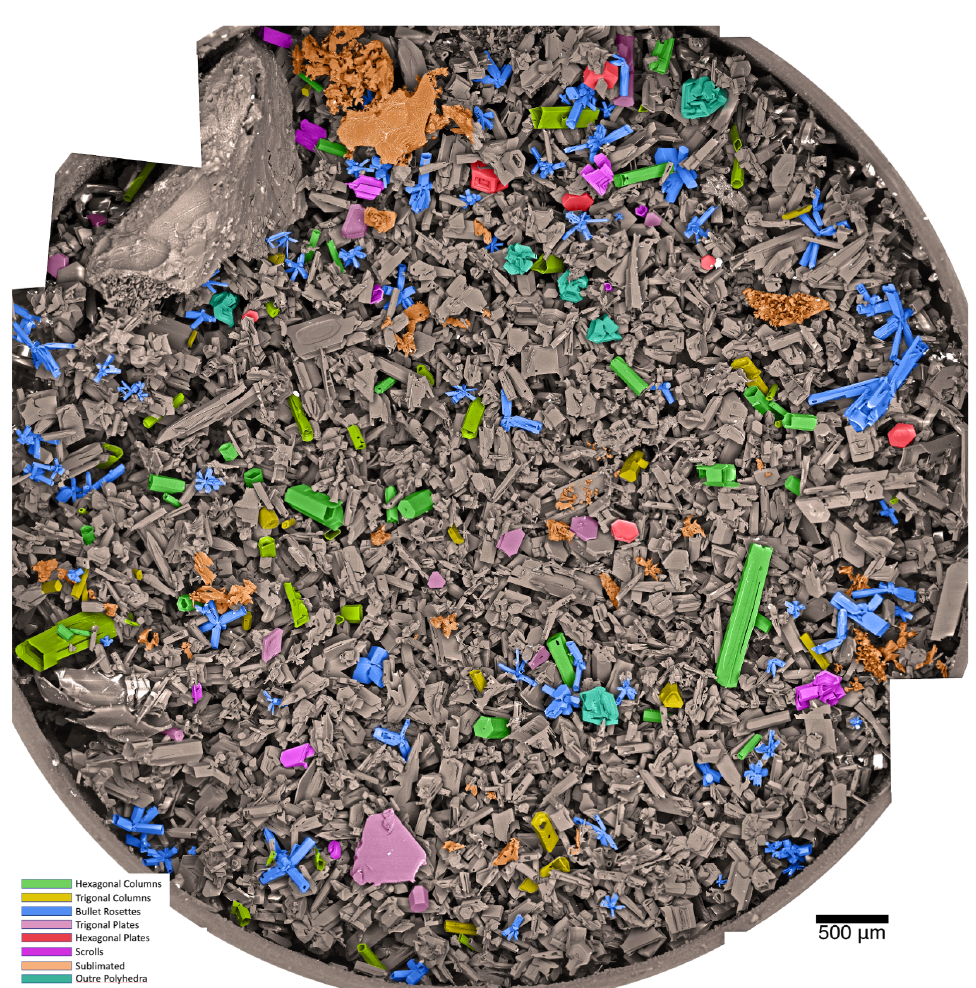
Figure 2. Mosaic of 50 cryo-SEM micrographs of cirrus ice particles captured on 24 April 2018 from ∼ 11km altitude at − 50 ◦ C. Each micrograph in this group was acquired at 100 × magnification with a resolution of ∼ 900nm. The actual large circle diameter is 7mm. False color shading groups similar crystal habits or highly sublimated particles (orange). Grayscale particles are sharply faceted crystals that do not easily fit in habit classification categories. Table 1 provides class counts and geometric